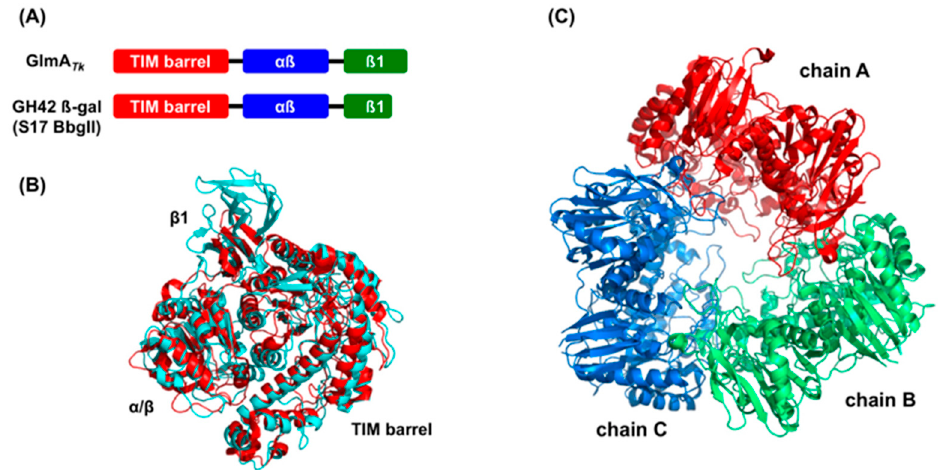
Figure 2. Structural comparison between GlmA Tk and GH42 β -galactosidases. The comparison was performed with five GH42 β -galactosidases, but, for clarity, only the result of BbgII (PDB 4UZS) is shown in the figure. ( A ) Schematic presentation of the domain organization of GlmA Tk and BbgII; ( B ) The superimposed models of the monomer structure of GlmA Tk (cyan) and BbgII (red). The figure was drawn in the same orientation as in the left panel of Figure 1B; ( C ) Trimeric structure of BbgII (chain A: red, chain B: green, chain C: blue).